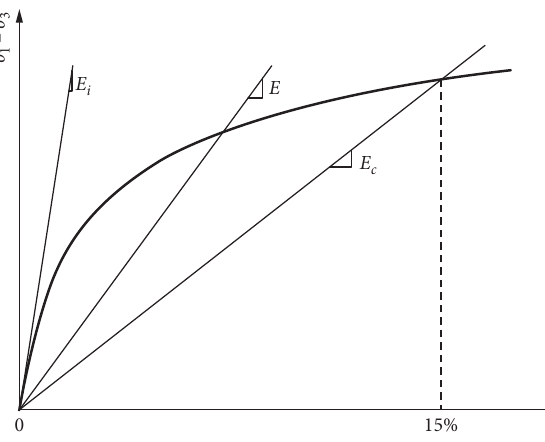
Figure 2: Determination of single-parameter disturbance